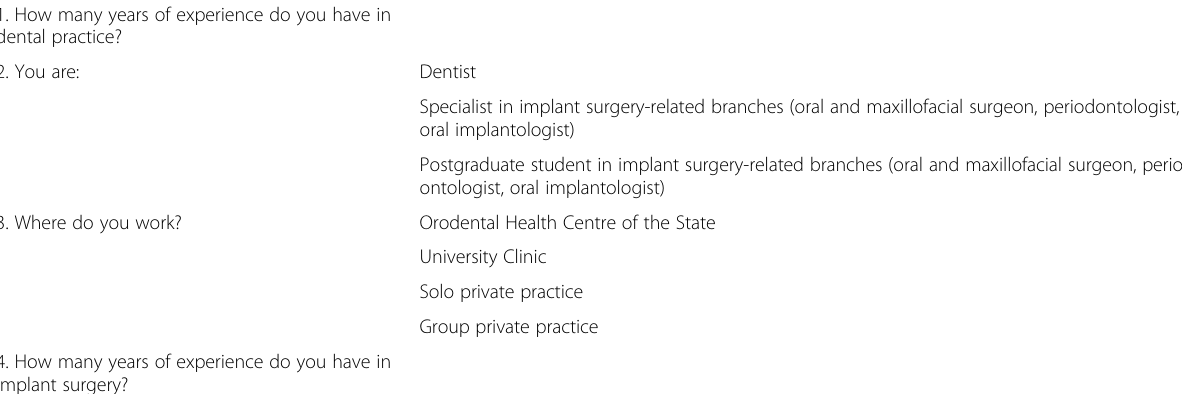
Table 1 Questions regarding qualifications of the